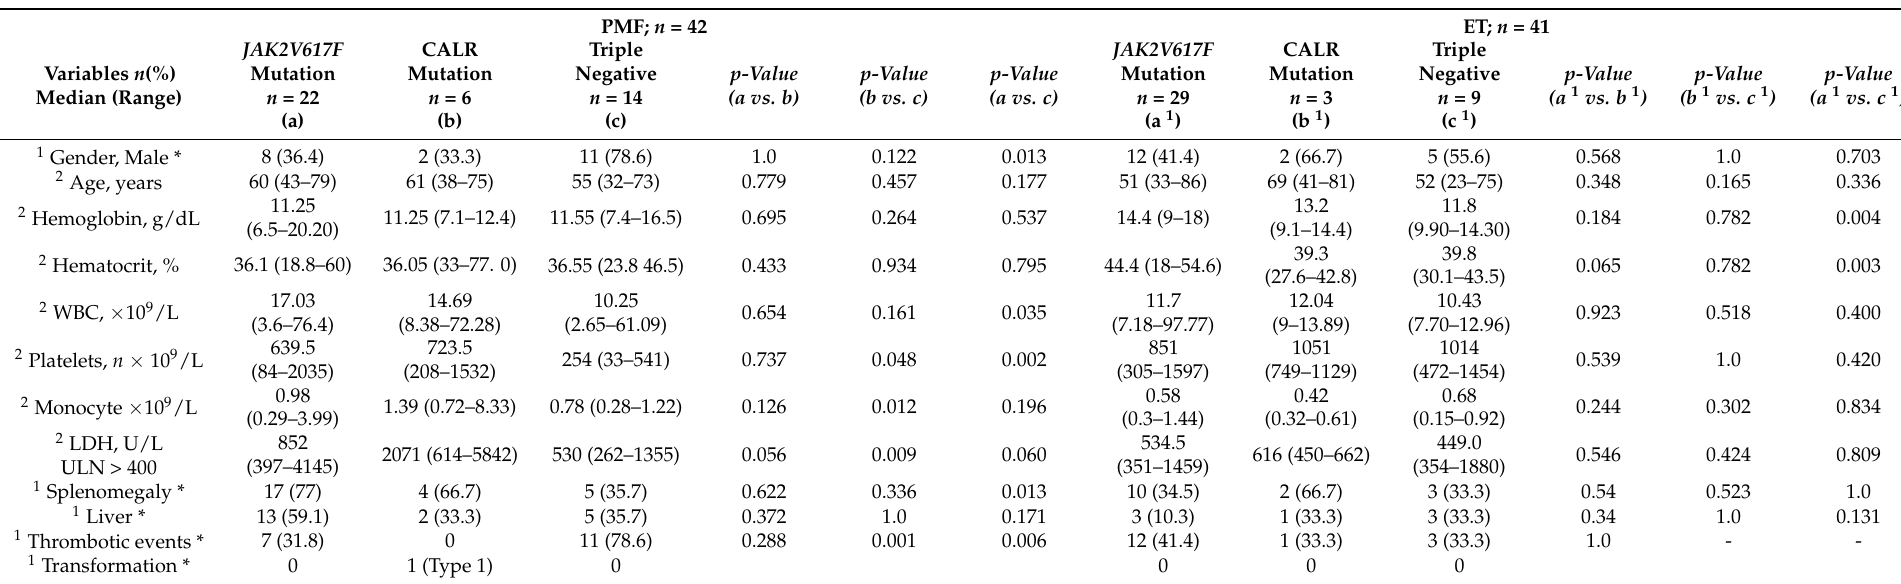
Table 4. Clinical and laboratory features of 41 Malaysian patients with PMF and 42 patients with ET, stratified according to mutation